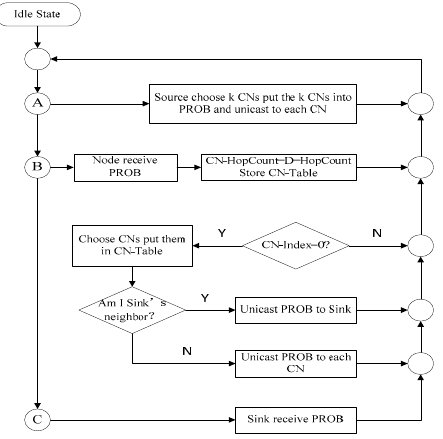
Figure 6. Algorithmic flow chart of multi-hop cooperative nodes.